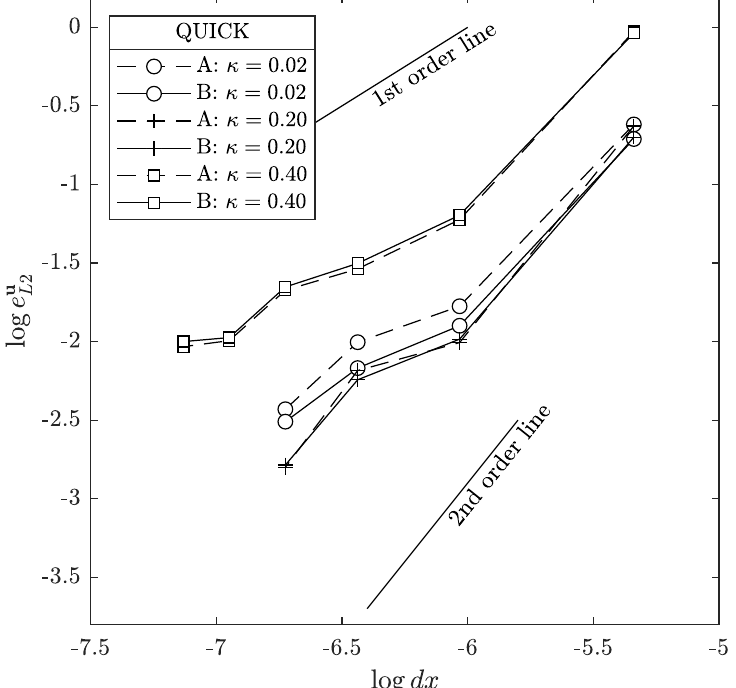
Figure 13. Velocity L 2 error norm as function of the interpolation schemes and κ parameter for the flow between concentric cylinders case using the QUICK